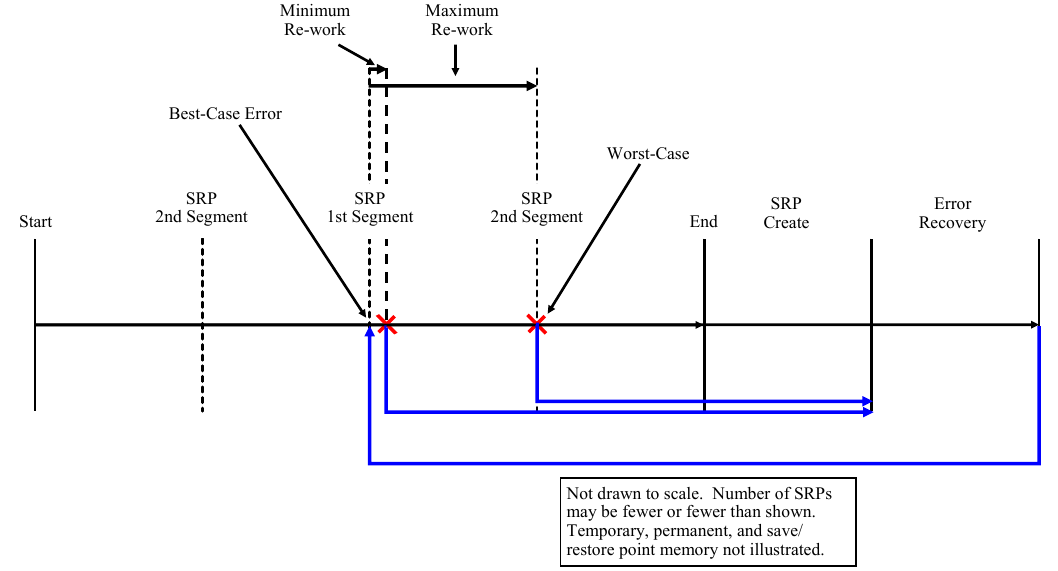
Figure A6. TSR MIPS Best- and Worst-Case error timing